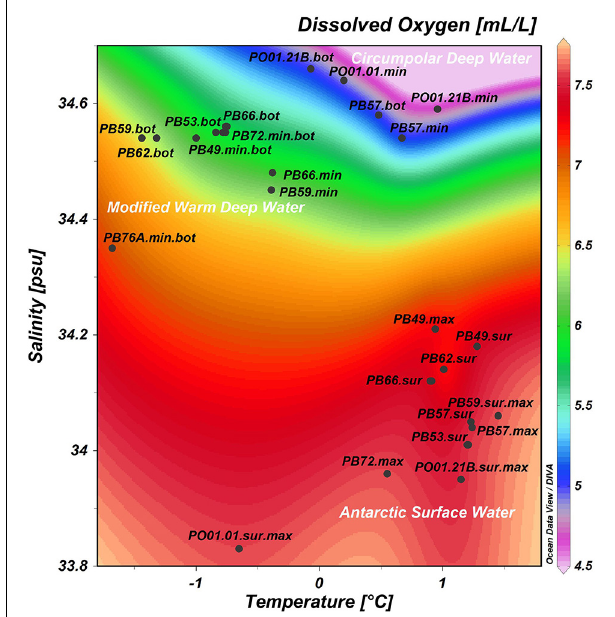
FIGURE 2 | Samples distribution according to in situ measurements of temperature ( ◦ C), salinity (psu) and dissolved oxygen (mL.L − 1 ). In white: water masses sampled in the Southern Ocean. Sur, surface; max, maximum ofdissolvedoxygen;min,minimumofdissolvedoxygen;bot,nearthebottom.